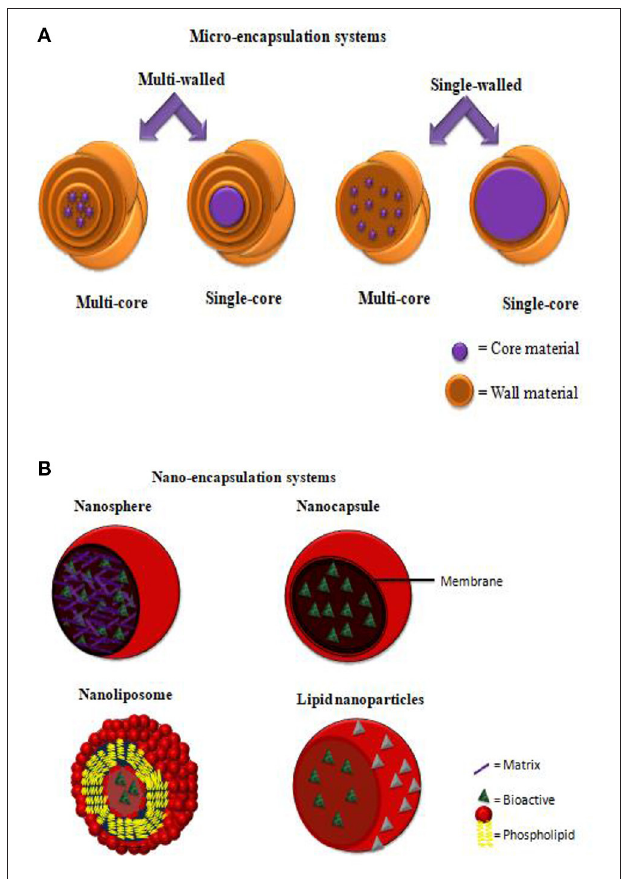
FIGURE 1 | (A,B) Encapsulation systems and their structures: microencapsulation and nanoencapsulation (Adapted from Delshadi et al., 2021 ).